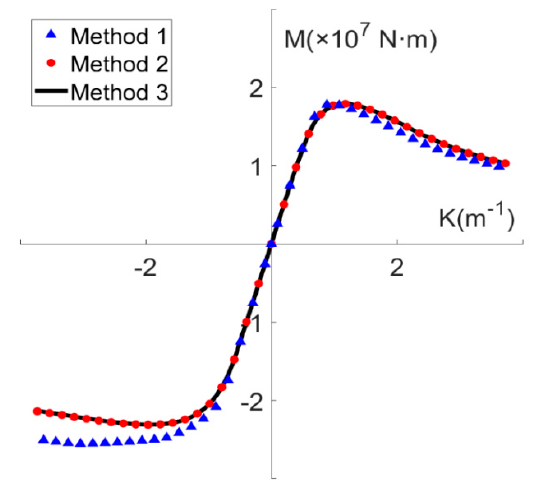
Figure 9. Bending moment in CASE 2.